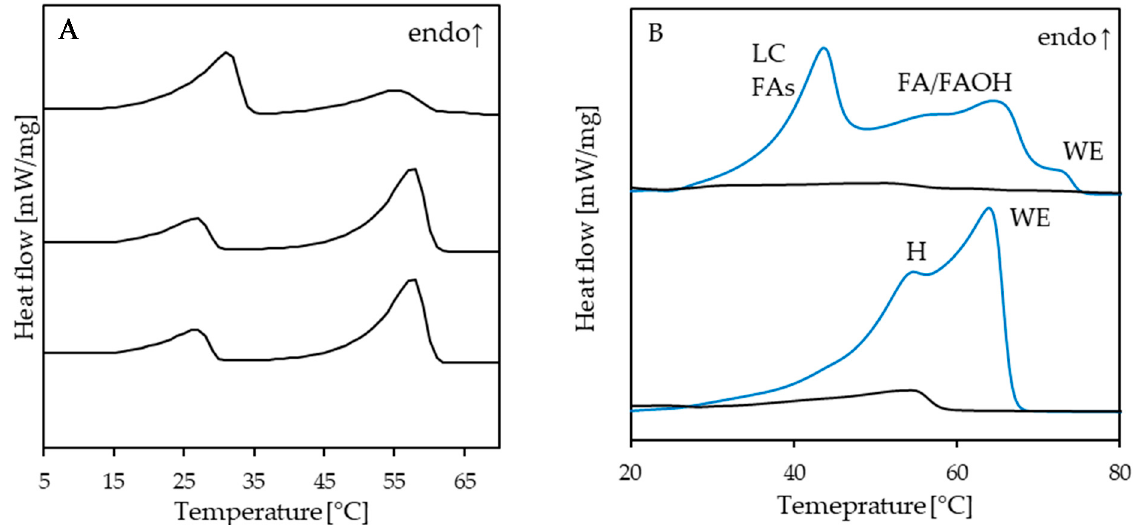
Figure 3. DSC heating thermograms; stabilization for 48 h at 5 °C, scan rate 5 K/min. ( A ): ternary mixtures composed of 90% ( w / w ) MCT oil, and 10% of mixtures of pure (>99%) wax esters; from top to bottom 2:1; 1:1, and 1:2 of palmityl–myristate (C16 FaOH and C14 FA) and behenyl–arachidate (C22 FaOH and C20 FA). [69]. ( B ): Blue curves: pure bees wax (top) and bees wax hydrolysate (bottom), black curves: their corresponding 12% w / w oleogels in canola oil. WE—wax esters, H—hydrocarbons, LC FAs—long-chain fatty acids, FAOH—fatty alcohol [67].